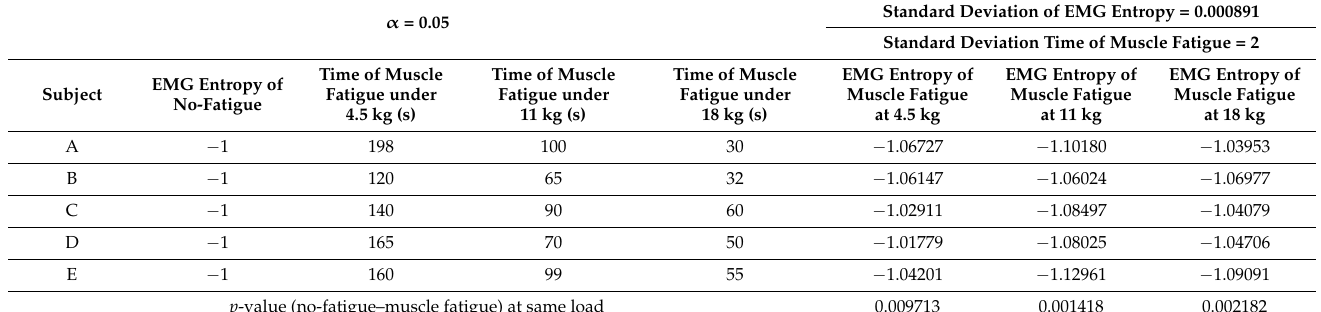
Table 3. The properties of muscle fatigue with parameters of time and normalized EMG entropy for each person. α = 0.05